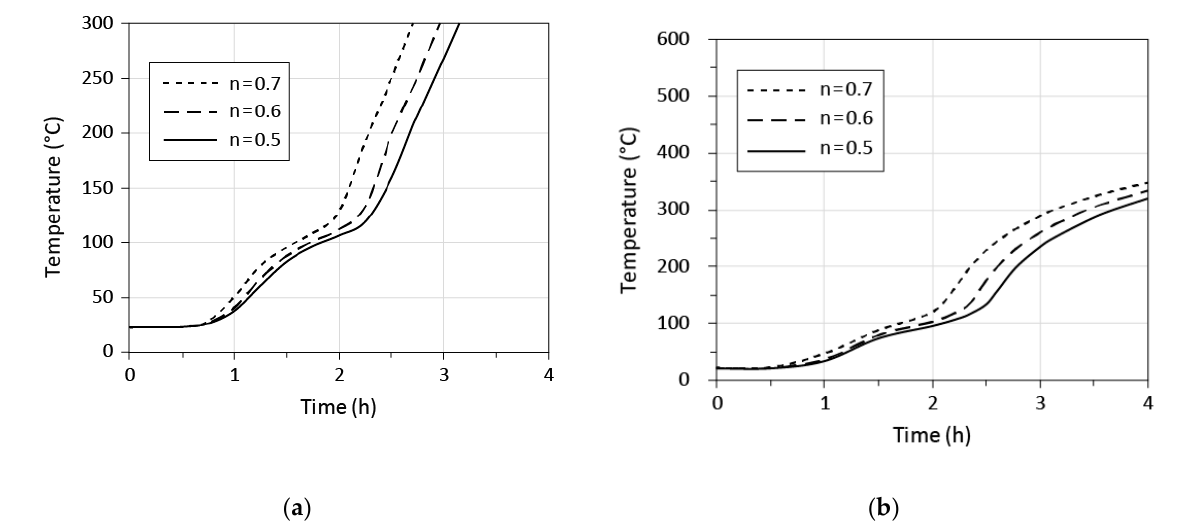
Figure 18. Temperature evolution at the top of a deck with a 7.5 cm growing medium layer at three different porosities ( n ): 0.5, 0.6, and 0.7 when exposed to 200 kW/m²; ( a ) wooden deck; ( b ) steel deck.